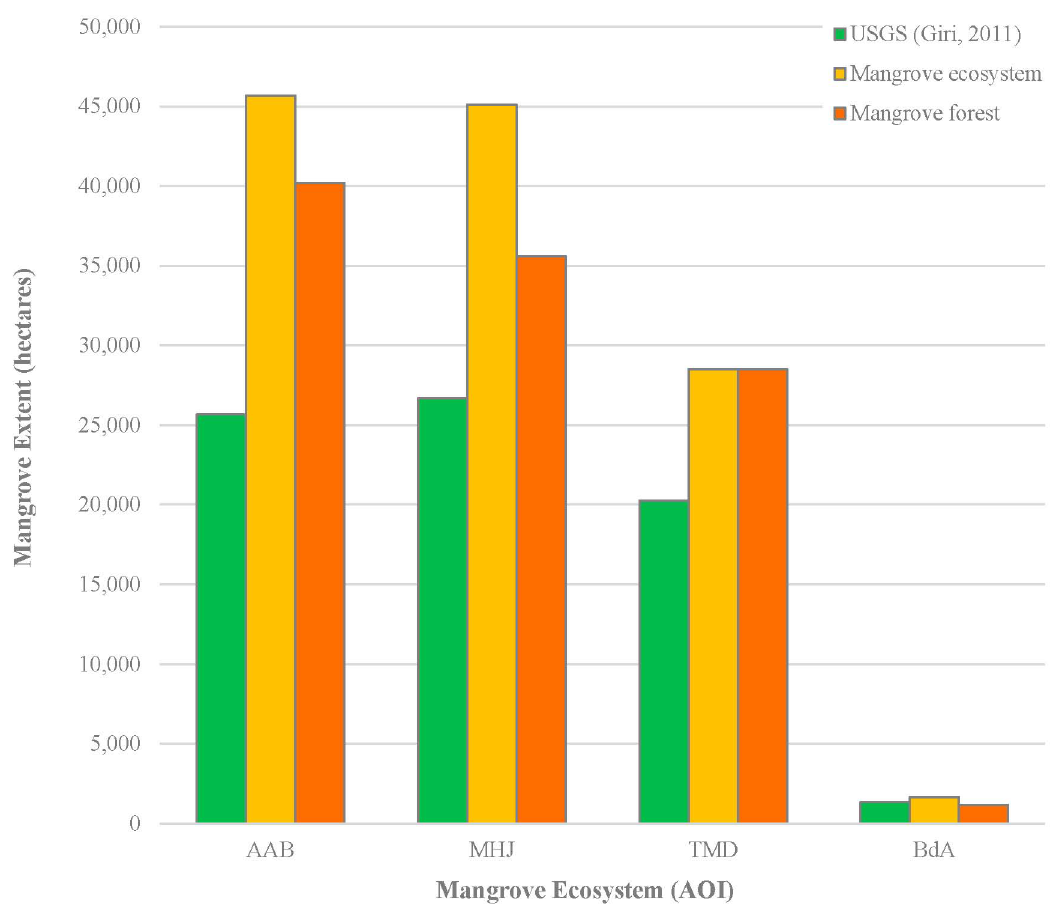
Figure 9. The extent of mangroves based on the 2010 national-level USGS-produced Landsat derived mangrove cover map [69] versus the results of AOI-specific contemporary mapping is shown for each AOI. For AOI-specific mapping results, extent is shown based on all mangrove classes including shrub/scrub dominated ( i.e. , mangrove ecosystem) and based on only classes meeting the definition of forest ( i.e. , mangrove